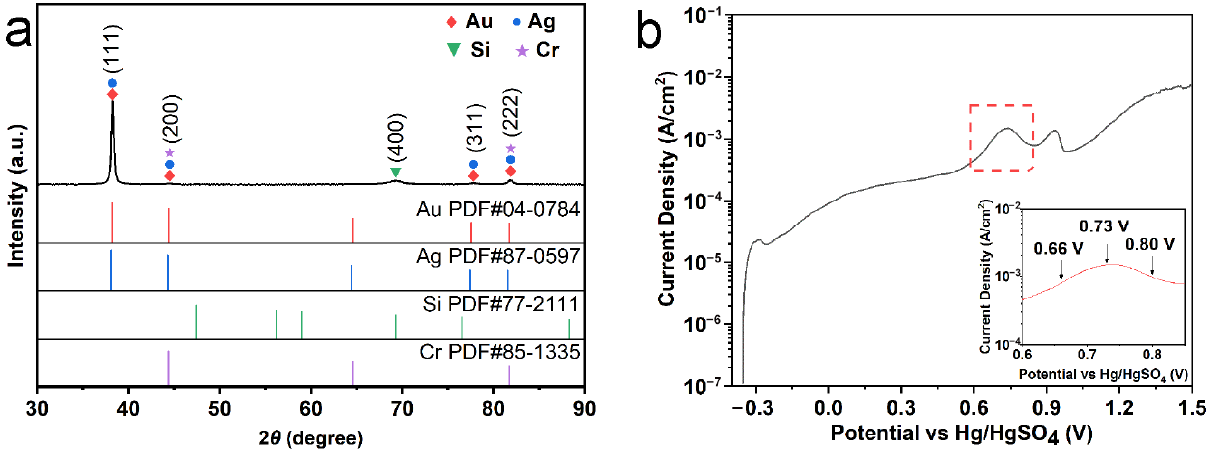
Figure 1. Characterization of the as-prepared Au-Ag film. ( a ) XRD diffractogram. ( b ) Potentiodynamic polarization curve.